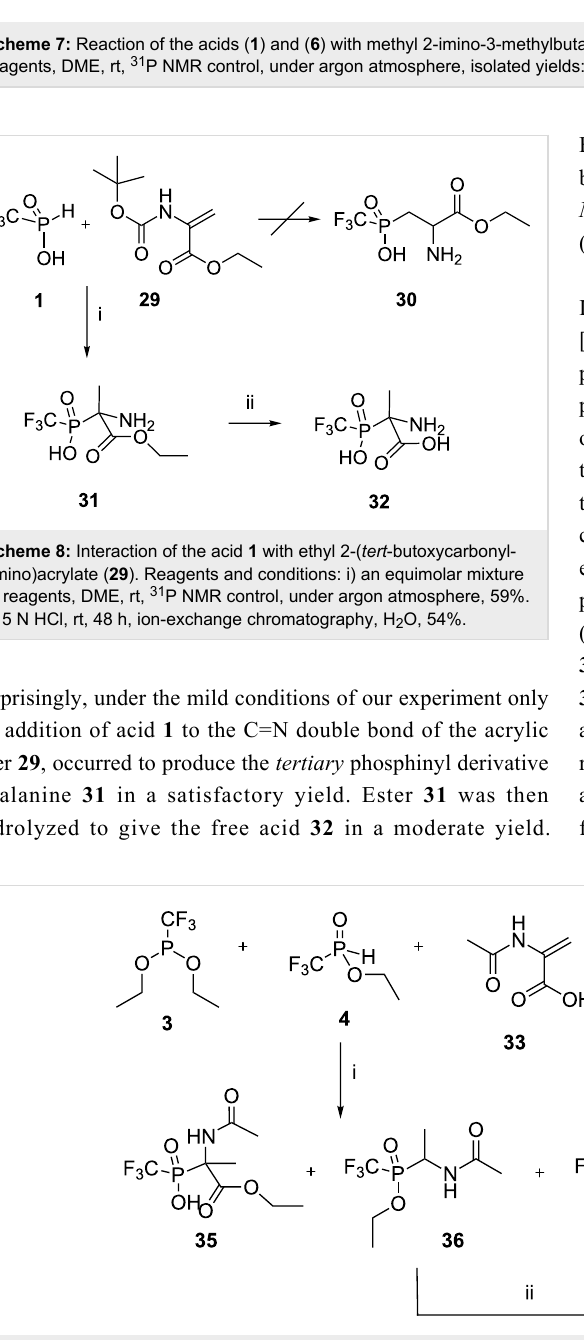
Scheme 9: Interaction of a mixture of the esters 3 and 4 with 2-acetamidoacrylic acid ( 33 ). Reagents and conditions: i) an equimolar mixture of 4 and 33 and 1.5 equiv of 3 , rt, 31 P NMR control, under argon atmosphere, isolated yields: 35 (7%), 36 (40%) (diastereomeric ratio ~8:7), 37 (18%). ii) 5 N HCl, rt, 24 h, 95%. iii) 5 N HCl, in an ampoule, 130 °C, 8 h, 34%.